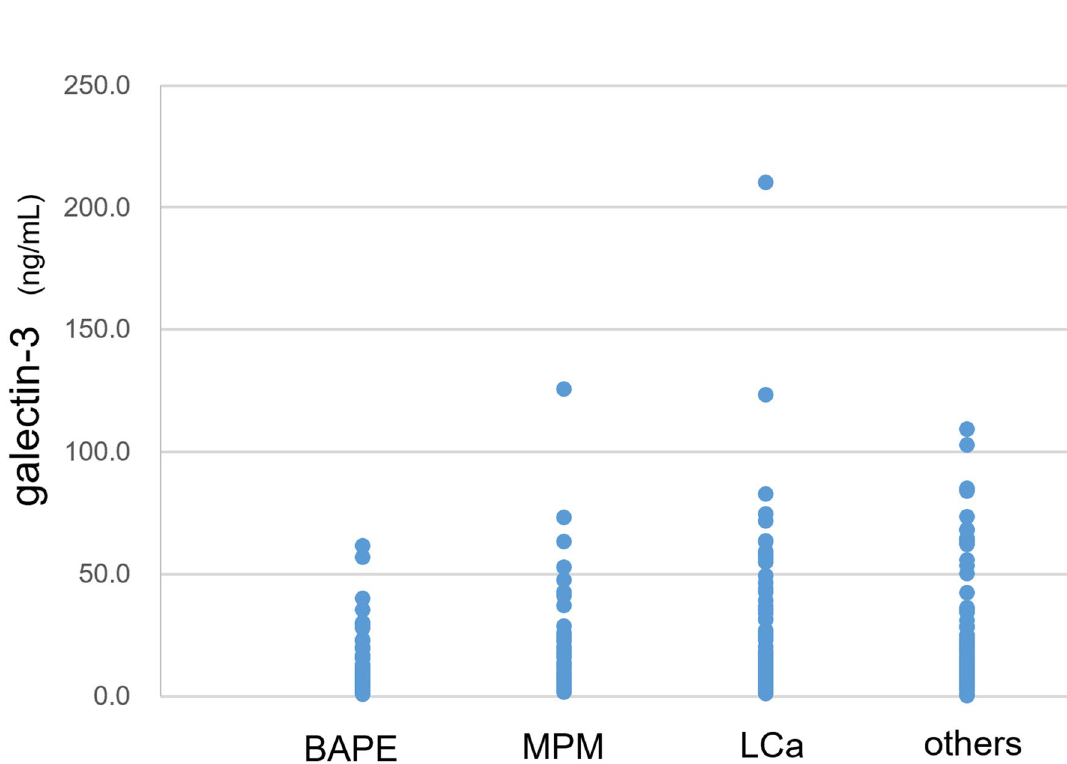
Figure 5. Galectin-3 levels in pleural effusion from patients with BAPE, MPM, LCA and other diseases. BAPE benign asbestos pleural effusion, MPM malignant pleural mesothelioma, LCA lung